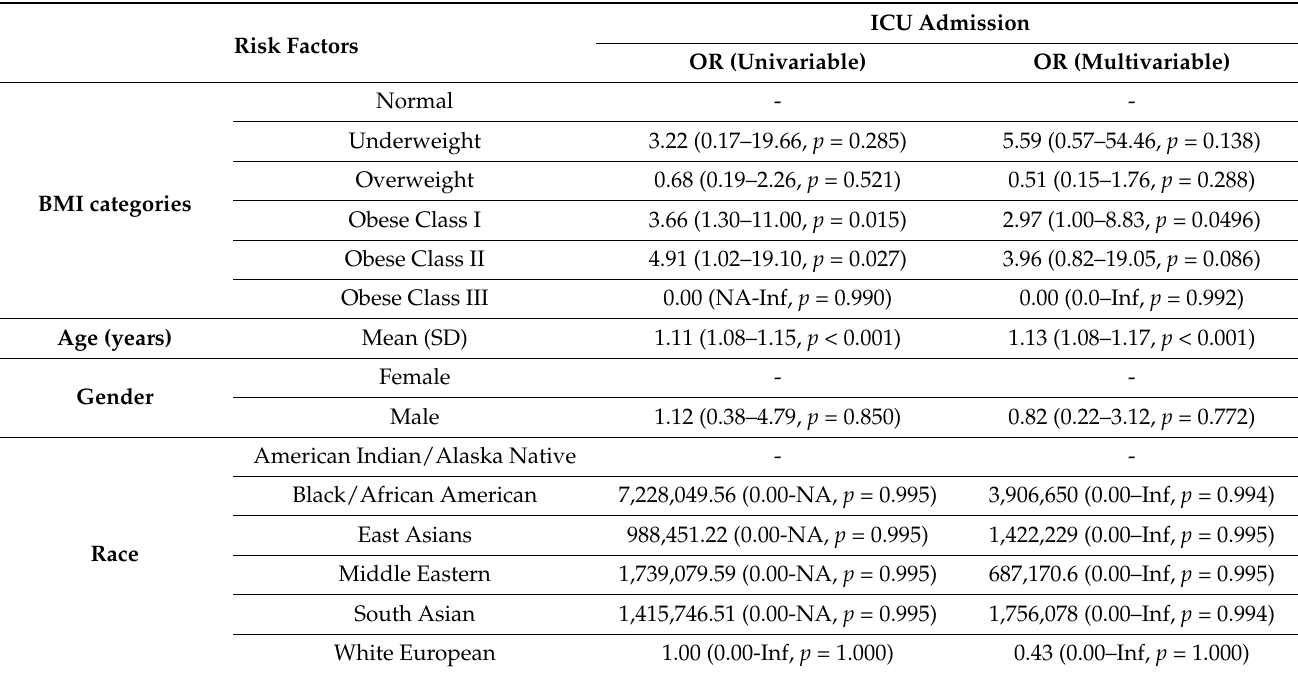
Table 4. Relationship between patient BMI and ICU admission among COVID-19